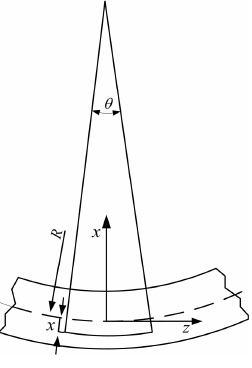
Figure 5. Beam stretching.